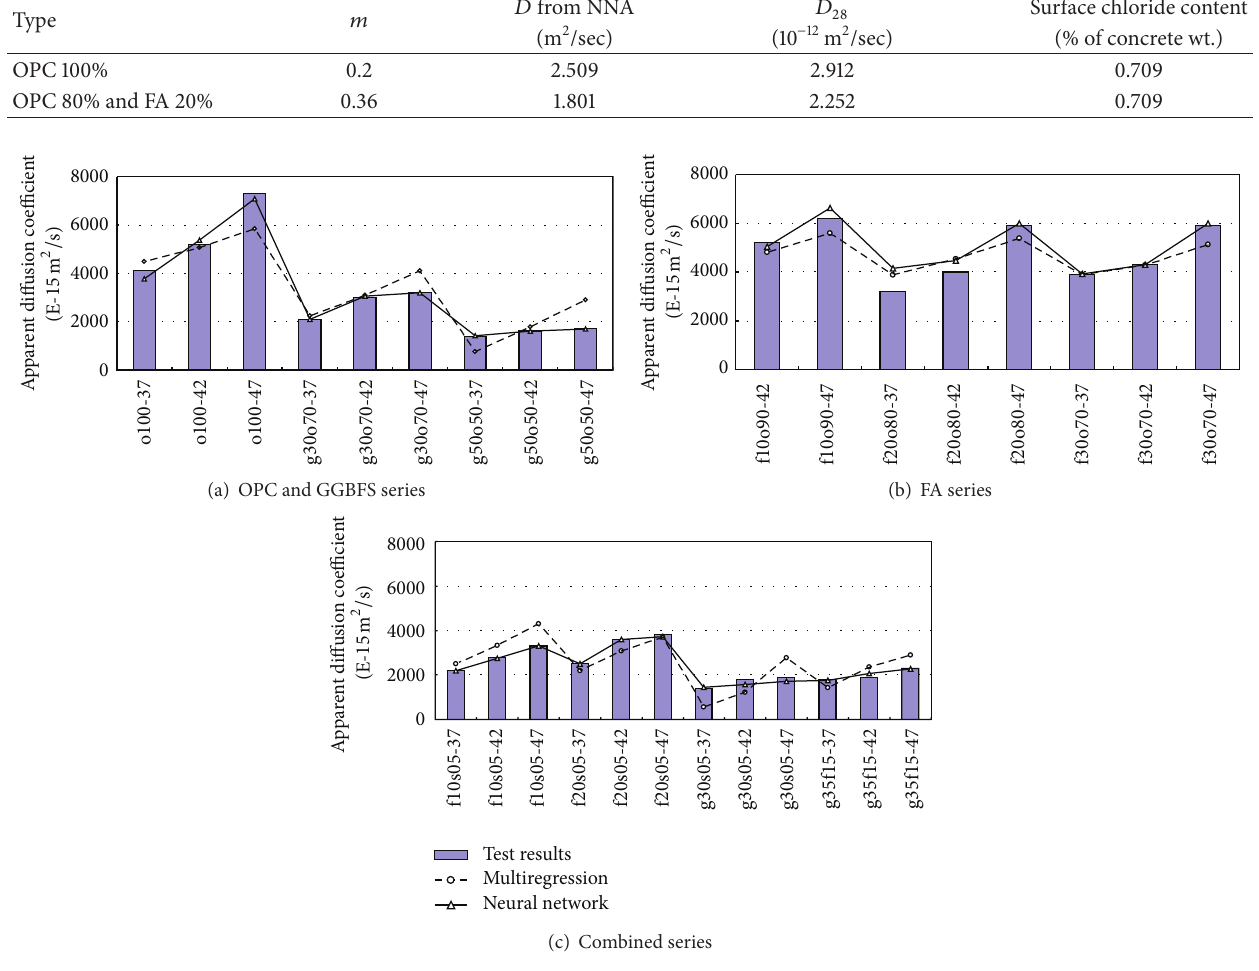
Figure 7: Comparison with results from test, multiregression, and